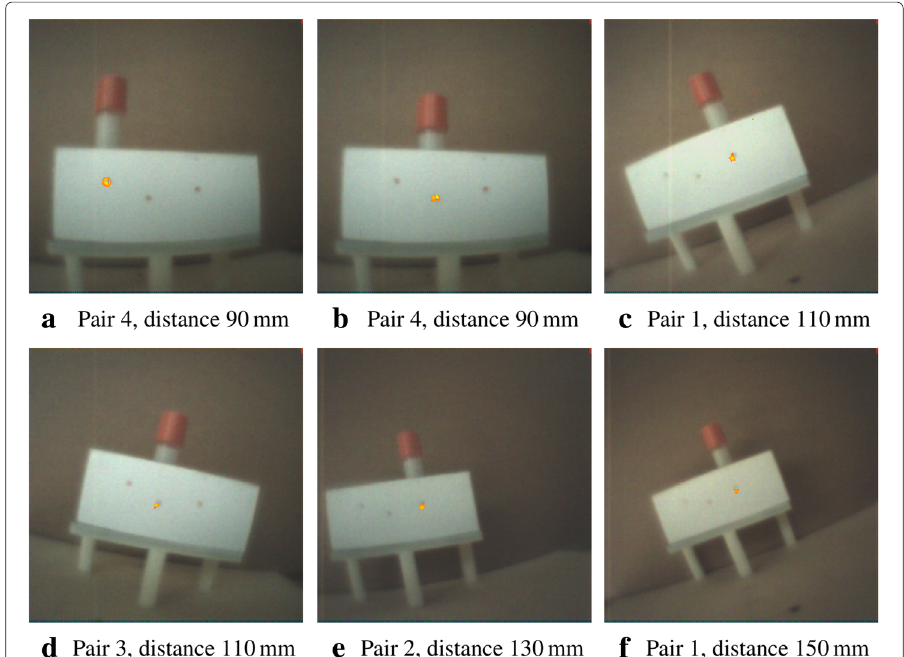
Fig. 19 A collection of different augmentation results on a neutral target, reusing the respective stored extrinsic calibration of each pair ( a - f